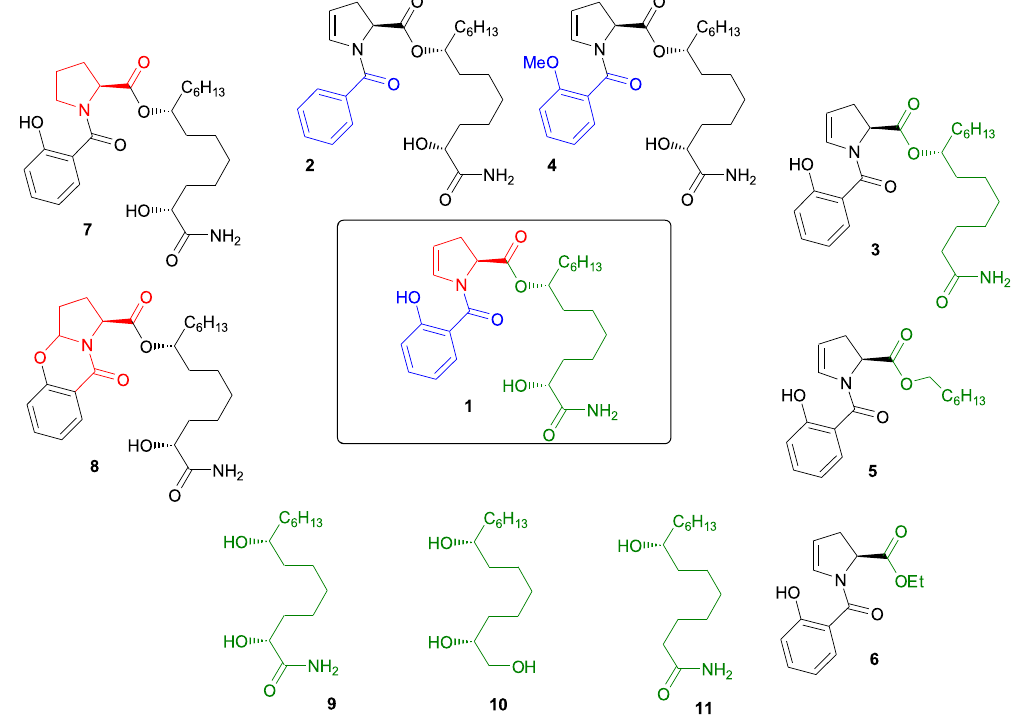
Figure 6. Structure of promysalin ( 1 ) and analogs ( 2 – 11 ).